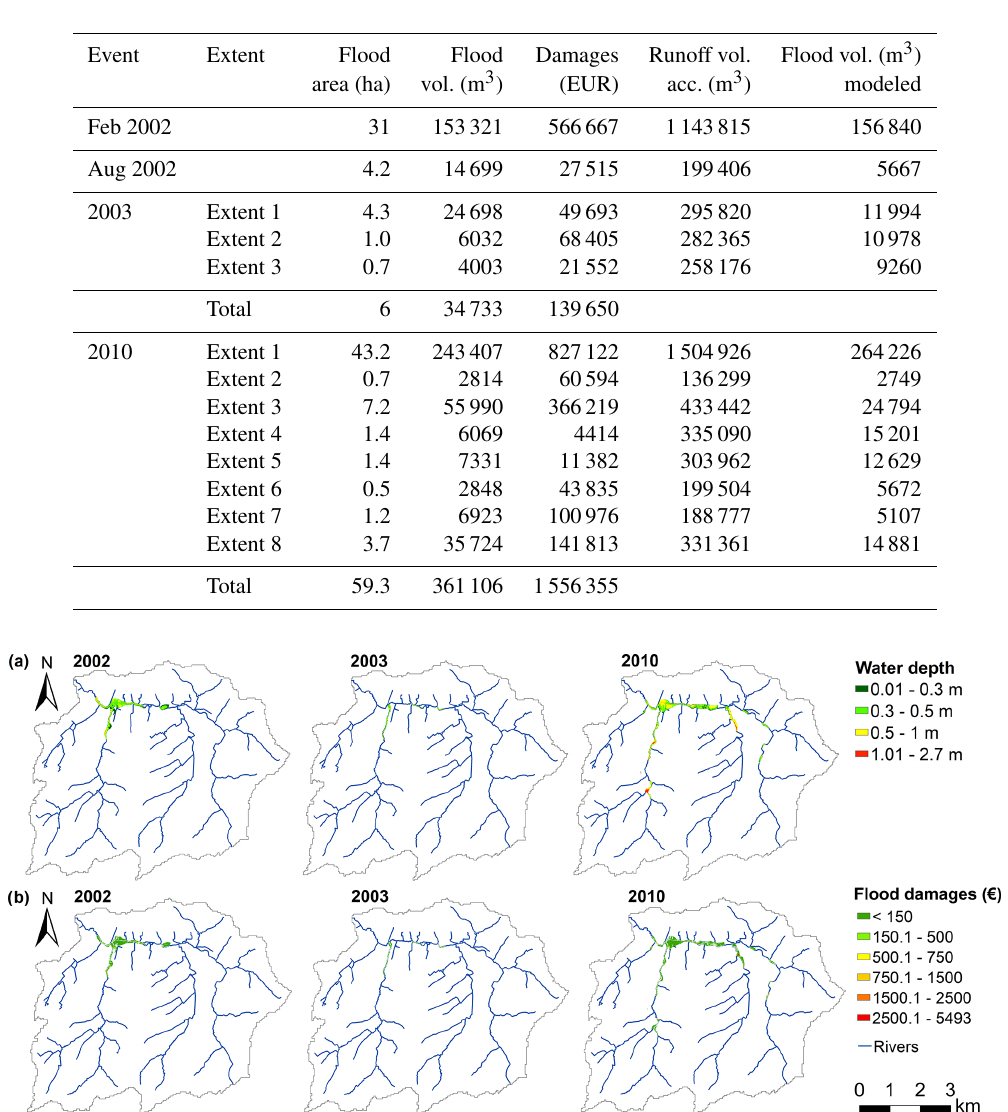
Table 2. Overview of the flooded area (ha), total observed flood volume (m 3 ), resulting flood damages (EUR), runoff volume accumulation at the flood extents’ outlet (m 3 ) and total modeled flood volume (m 3 ) for each of the four observed flood events and their corresponding flood extents.